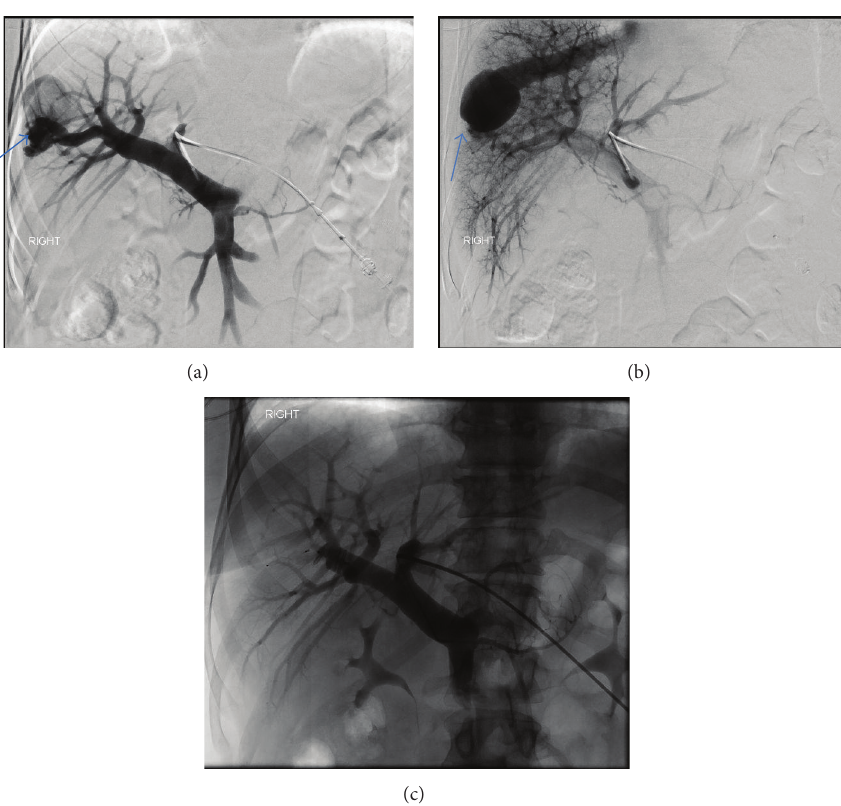
Figure 5: A 45-year-old female with intrahepatic portosystemic venous shunt with associated aneurysms. (a) Portal venography obtained via left portal vein with catheter tip in the main portal vein demonstrates a right anterior portal vein branch communicating with the right hepatic vein through a 28 mm aneurysm (arrow). (b) Portal venography obtained via left portal vein with catheter tip in the main portal vein shows a right posterior portal vein branch communicating with the right hepatic vein through a second, larger, 37 mm aneurysm (arrow). (c) Portal venography performed after embolization of both anterior and posterior right portal branches communicating with the right hepatic veins with Amplatzer vascular plugs demonstrates obliteration of intrahepatic portosystemic shunts. Protocol: Single Plane Artis Zee Siemens system, embolization with a 12mm and 6mm Amplatzer vascular plug ( St Jude Medical) . Table 1: Summary of intrahepatic portosystemic